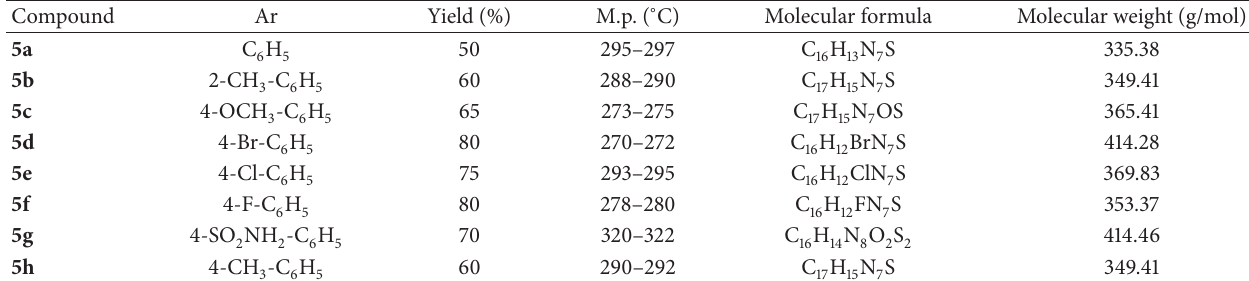
Table 1: Some properties of the synthesized compounds 5a–h .